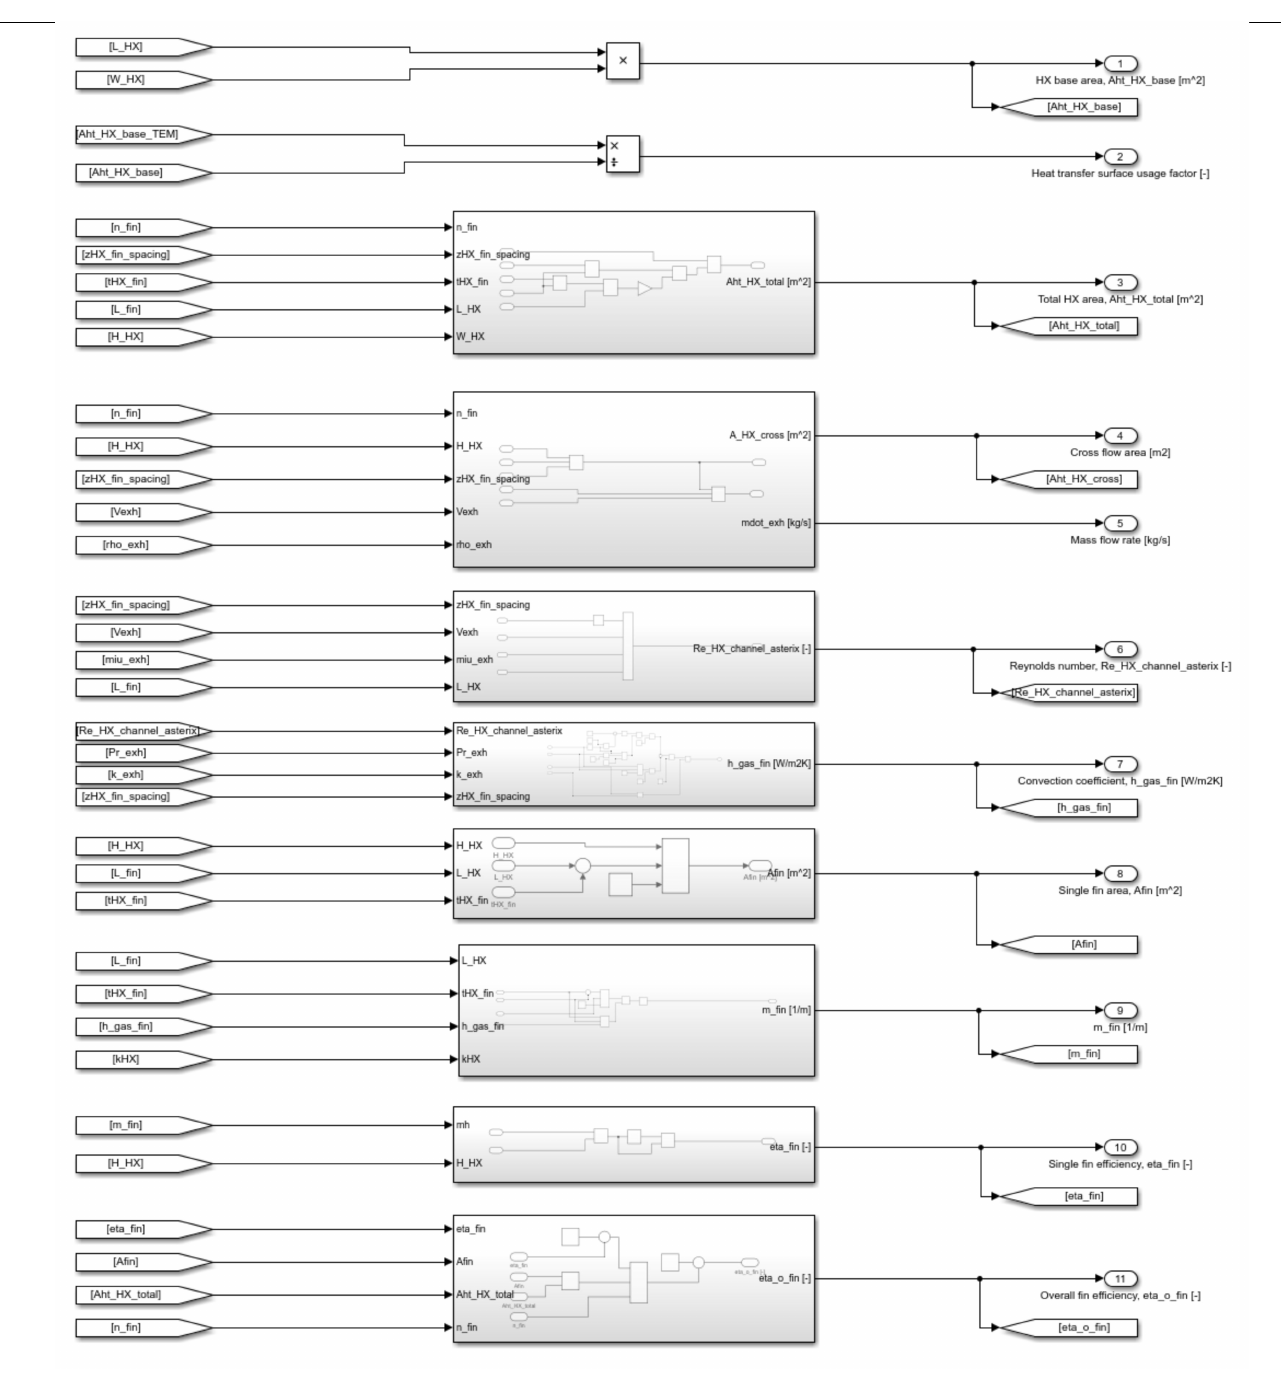
Figure A3. Hot side heat exchanger block—HX heat transfer equations and